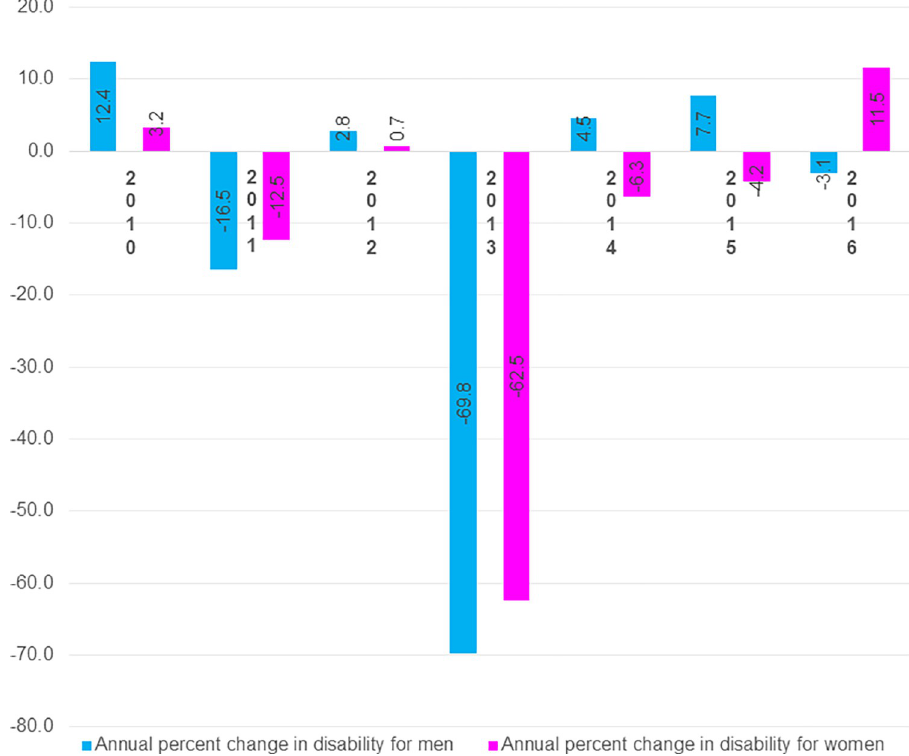
Fig 2. Annual percent change in disability by gender at age 60 from 2010 to